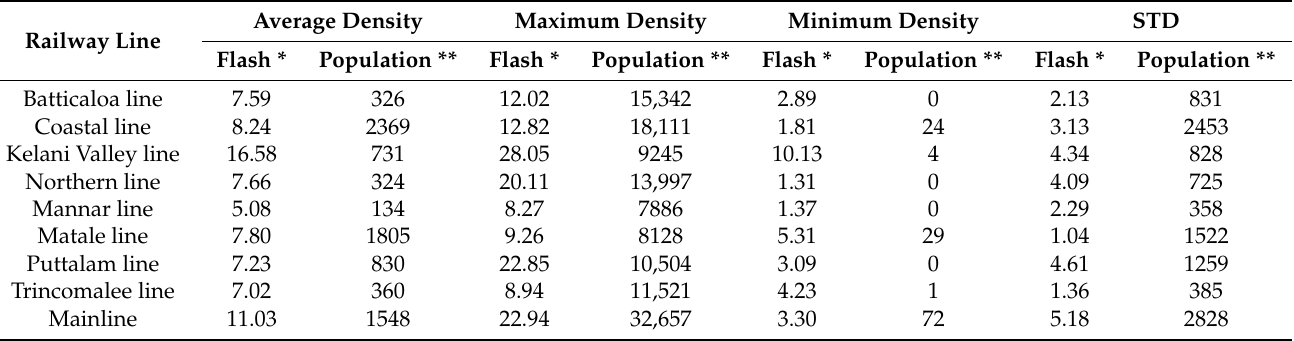
Figure 4. Spatial variability of the ( a ) annual lightning flash density (1998 – 2014) and ( b ) population density (2020) over the railway network of Sri Lanka. Table 2. Statistical overview of the annual lightning flash density (flashes/(km 2 ⋅ year)) distribution and population density variation over the considered buffer area of the railway line from 1998 to 2014.